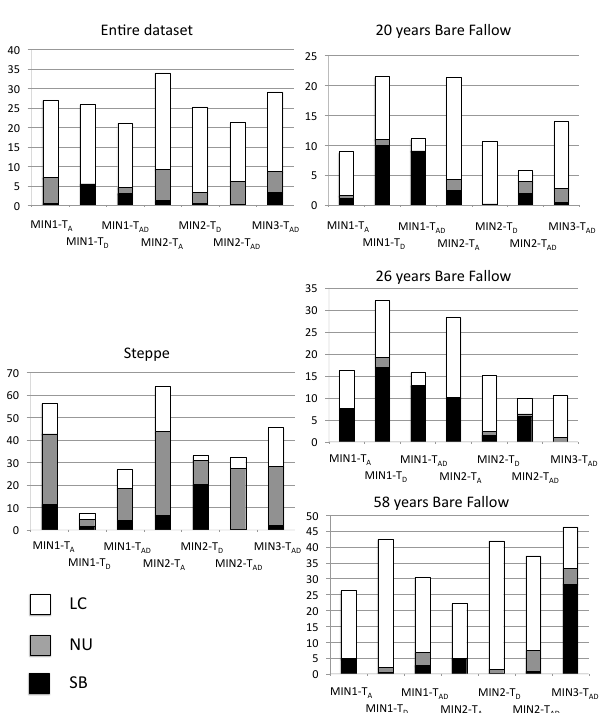
Fig. 3. Components of mean squared deviation (MSD) for the seven formulations. The lowest the MSD value is, the best the fit is. The three components are lack of correlation (LC), non-unity slope (NU), and squared bias